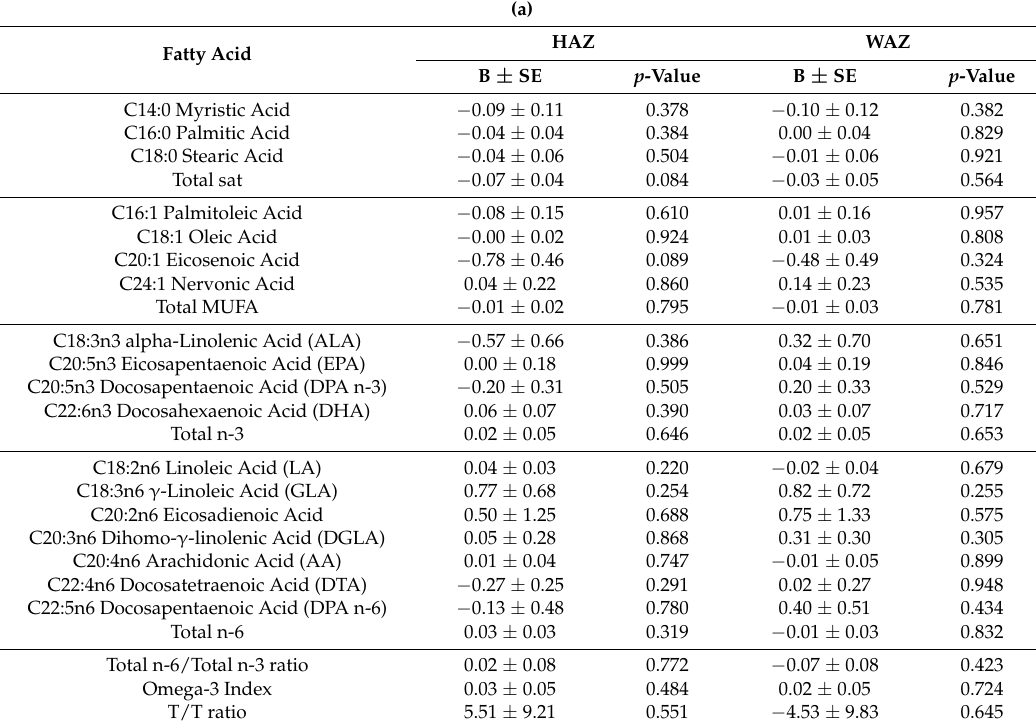
Table 4. ( a ) Regression results between HAZ, WAZ and selected fatty acids. ( b ) Regression results between WHZ, BAZ and selected fatty